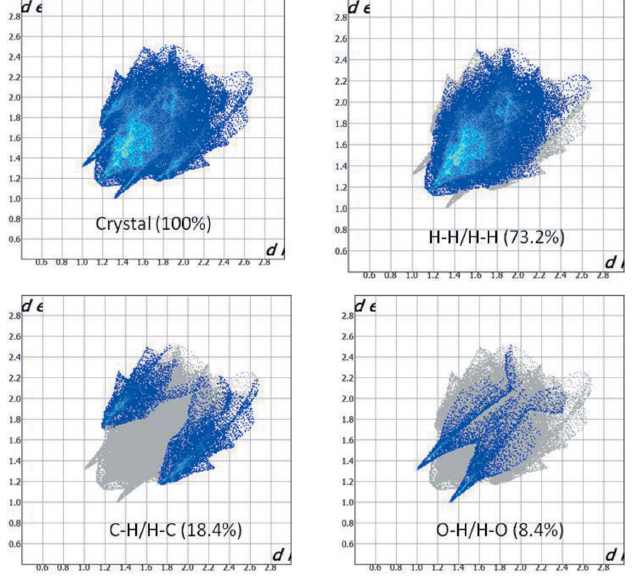
Figure 7 Two-dimensional fingerprint plot for the title compound showing the contributions of individual types of interactions (all intermolecular contacts, H (cid:3)(cid:3)(cid:3) H contacts, C (cid:3)(cid:3)(cid:3) H/H (cid:3)(cid:3)(cid:3) C contacts and O (cid:3)(cid:3)(cid:3) H/H (cid:3)(cid:3)(cid:3) O contacts).